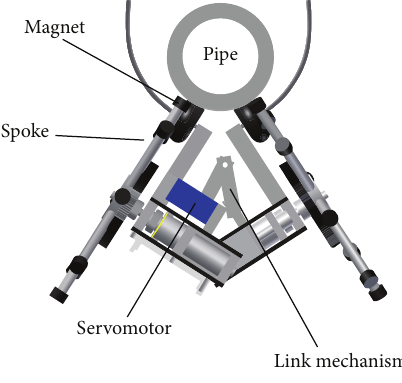
Figure 2: Robot attached to